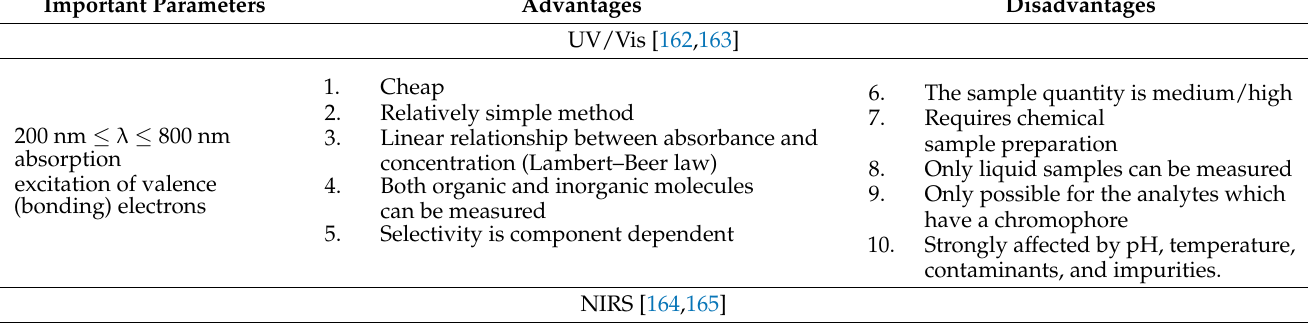
Table 2. Advantages and disadvantages of different molecular spectroscopy methods.